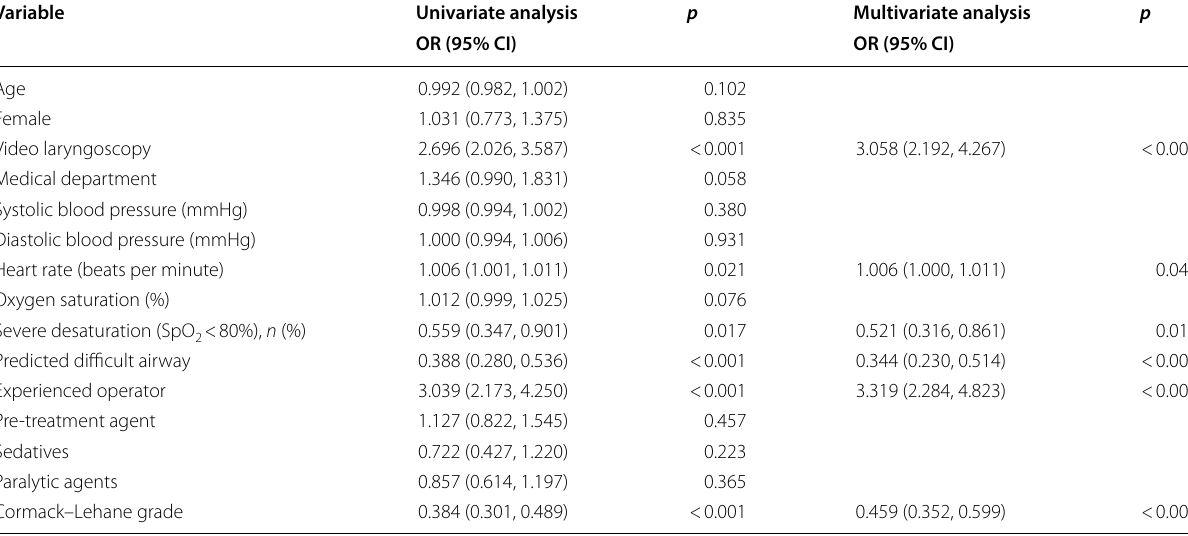
OR odds ratio, CI confidence